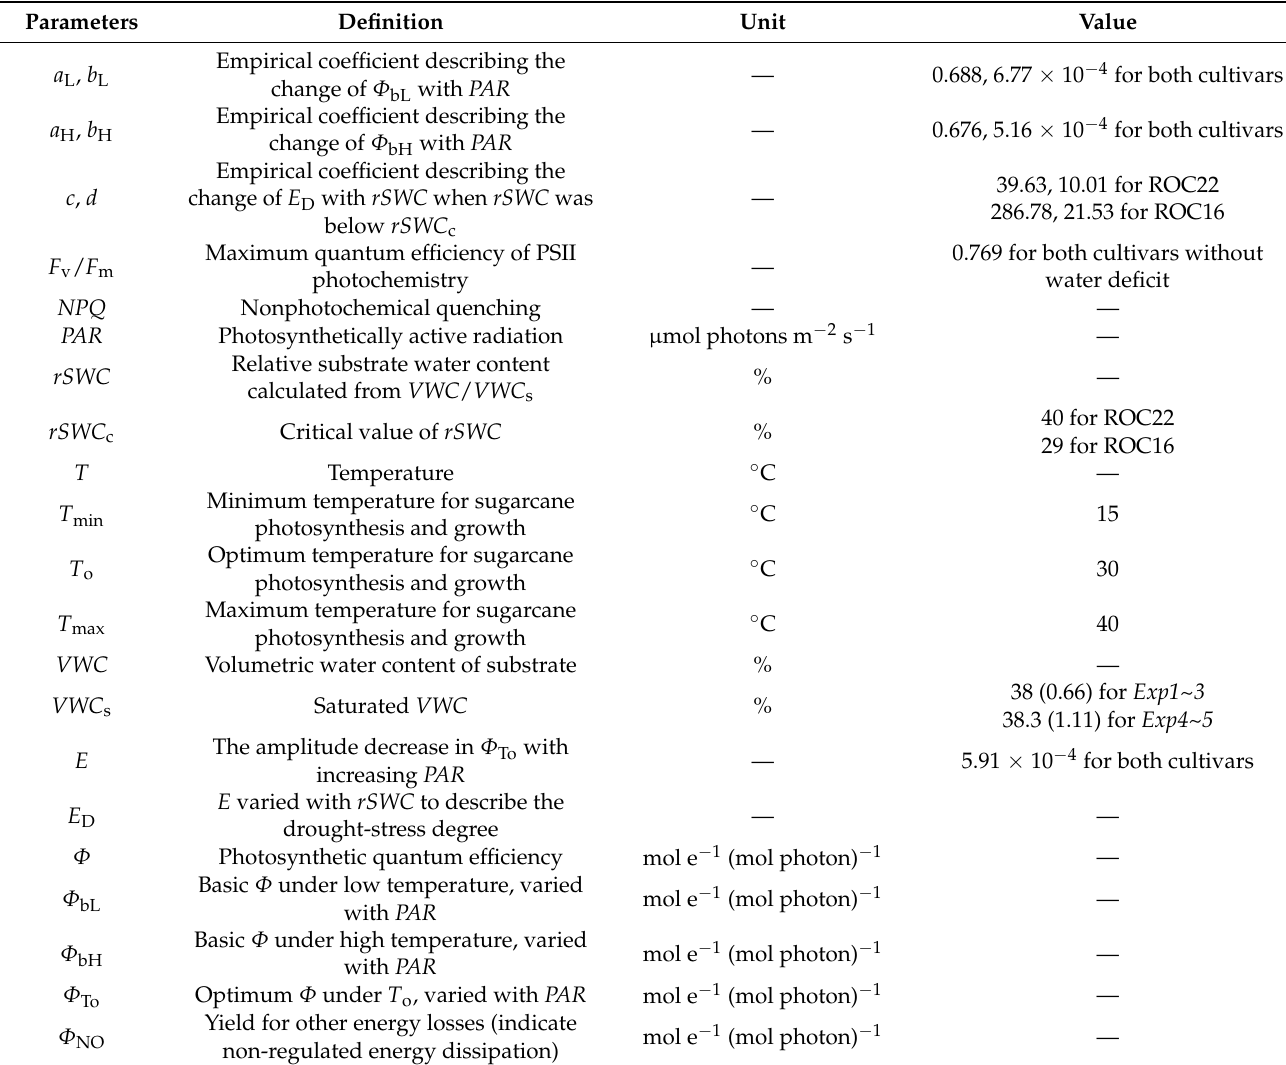
Table 1. List of parameters and empirical coefficients with definitions, units, and values (standard error shown in brackets) determined in this